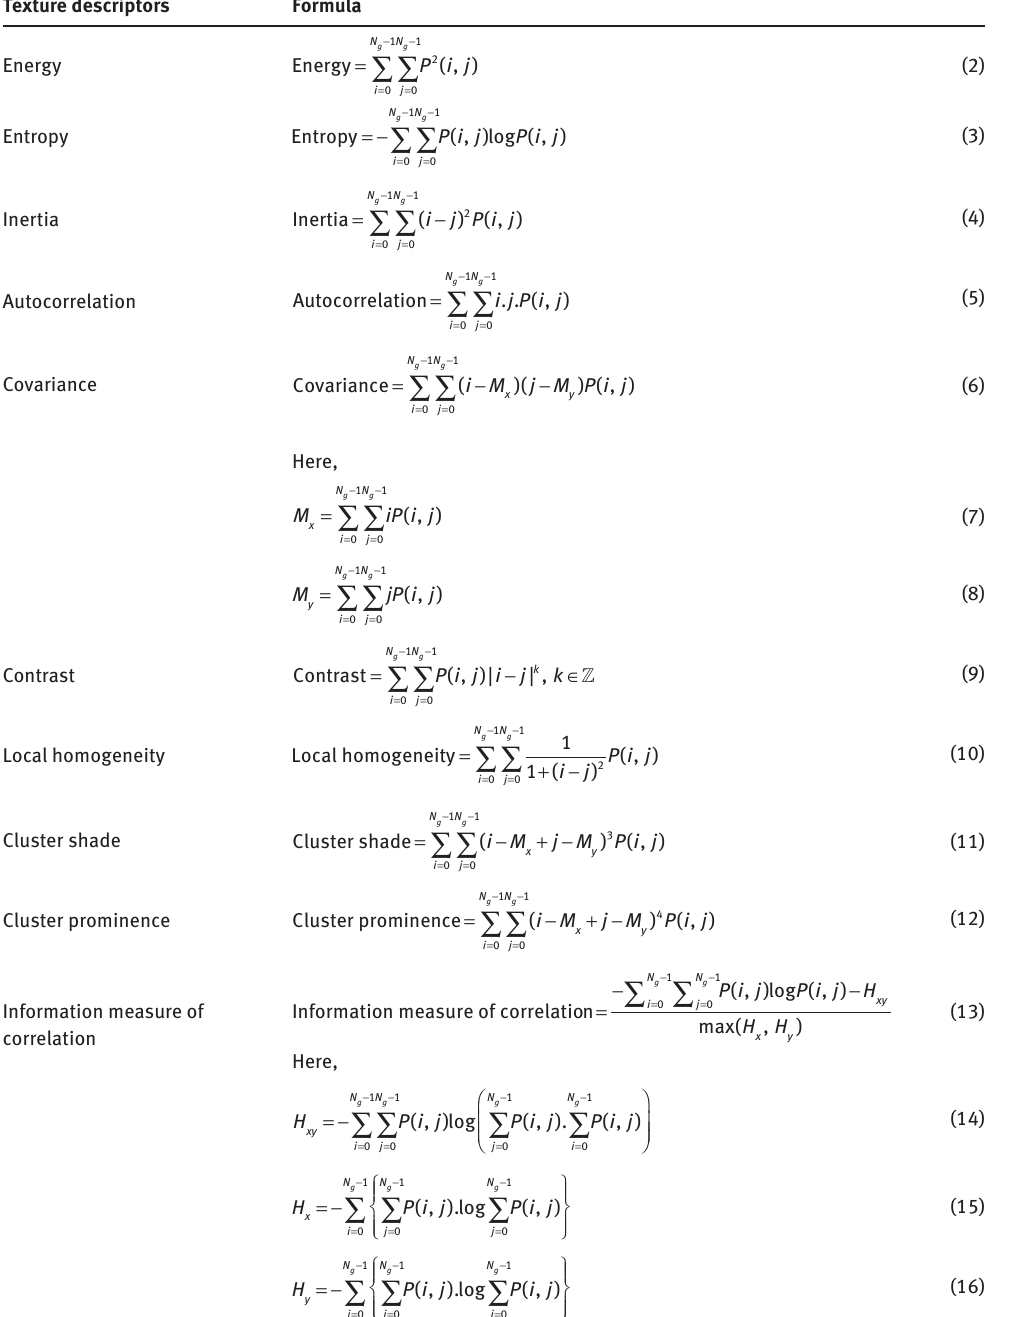
Table 1: Standard GLCM Texture Descriptors